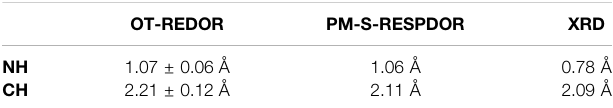
TABLE 2 | 1 H- 14 N distances measured by OT-REDOR, PM-S-RESPDOR, and XRD on